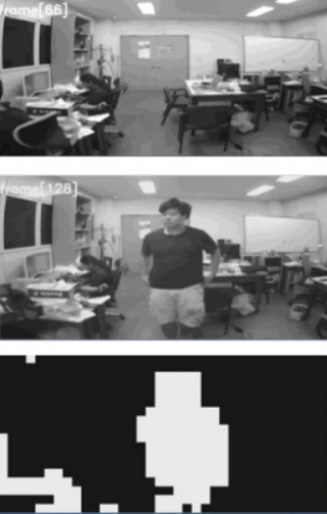
Figure 3. Extraction of Foreground Region.